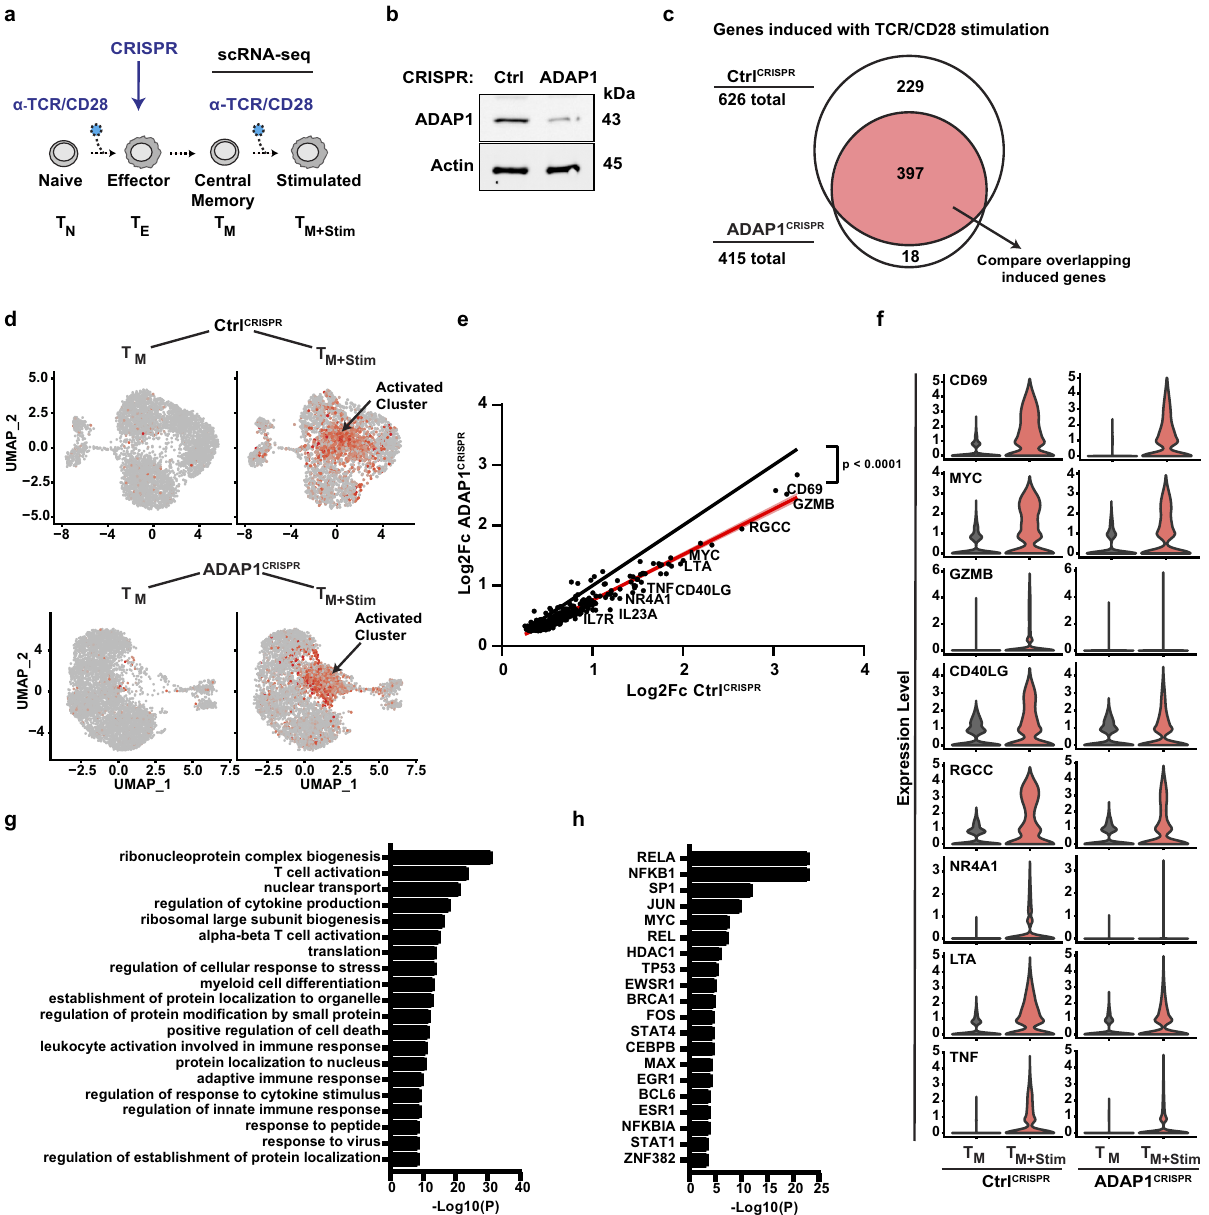
Fig. 5 Loss of ADAP1 in primary human CD4 + T cells dampens transcriptional gene programs upon stimulation. a Schematic of the generation of ADAP1 CRISPR and Ctrl CRISPR T M subjected to scRNAseq analysis. b Representative western blot analysis of primary T M (ADAP1 CRISPR and Ctrl CRISPR ) engineered through CRISPR-Cas9 ( n = 4 donors). c scRNAseq analysis of resting and stimulated (4 h) ADAP1 CRISPR and Ctrl CRISPR T M . Differentially expressed genes (DEG) were identi fi ed by comparing resting and stimulated T M within each sample set. Results of induced genes are summarized in Venn diagram. The overlapping induced genes (red) are those upregulated in both ADAP1 CRISPR and Ctrl CRISPR samples sets albeit at different levels (see text for details). d Induced genes were used to compare level of fold changes between ADAP1 CRISPR and Ctrl CRISPR samples. Select gene markers (highlighted in e , f ), were used to visualize the cells (red dots) expressing induced genes which mapped to a cluster that appeared during stimulation and are referred to as activated cluster. e Graph of induced genes ( n = 397) found in both ADAP1 CRISPR and Ctrl CRISPR sample sets comparing level of Log 2 Fc in respective samples. Using linear regression and F -test, the slope of sample data sets (red line, r 2 = 0.9285, Y = 0.7559 X + 0.001903, F (DFn, DFd) = 535.2 (1, 395), 95% con fi dence in light shaded red) was compared to the null hypothesis (black line, r 2 = 1.000, Y = 1.000 X ) of no difference in gene induction between ADAP1 CRISPR and Ctrl CRISPR samples. Select induced genes were highlighted. f Violin plots displaying mean expression level of induced genes at the single cell level (resting T M are in gray and stimulated T M are in red). Genes are also highlighted in e . g Gene ontology and h predicted TFs regulating the differentially expressed, induced genes. Analysis performed using ToppGene Suites 53 . Source data are provided as a Source Data fi